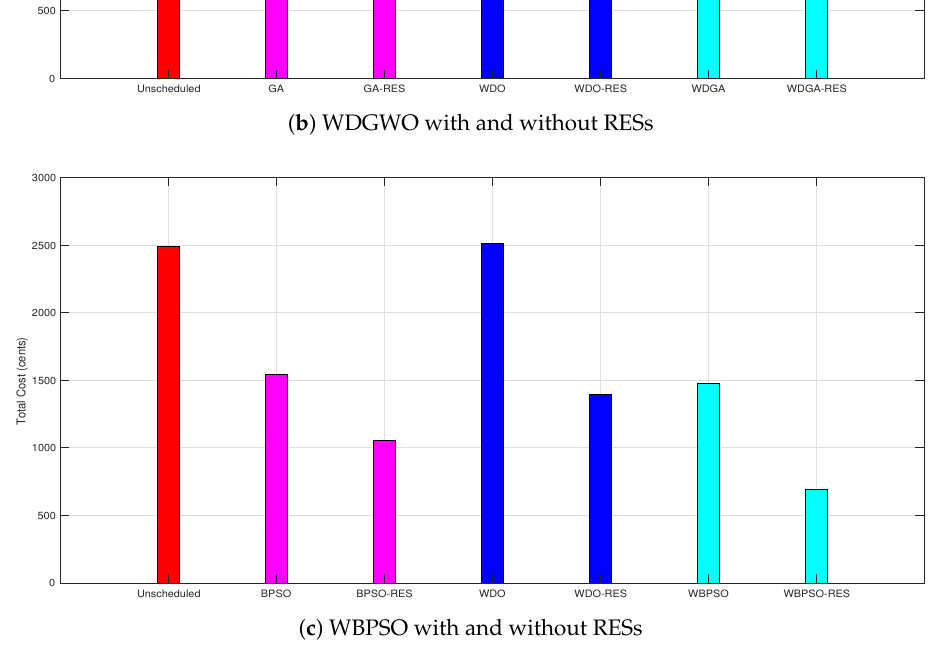
Figure 10. Total electricity